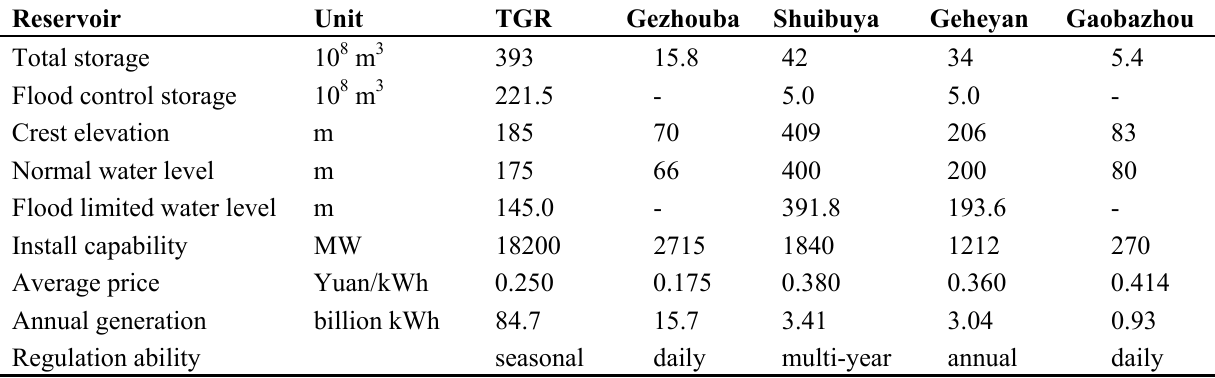
Table 1. List of characteristic parameter values of these five